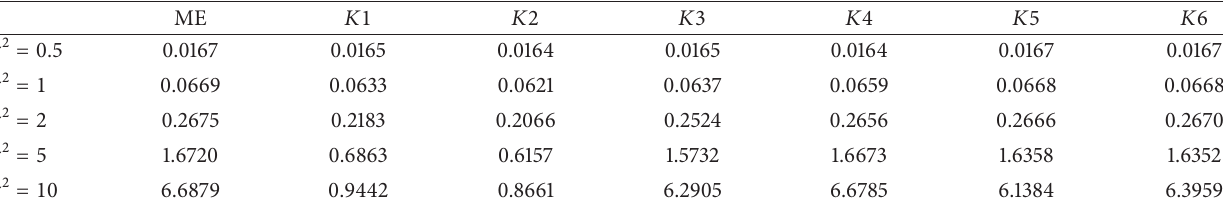
Table 2: Estimated MSE with 𝑛 = 50 , 𝑝 = 4 , and 𝛾 = 0.85 .